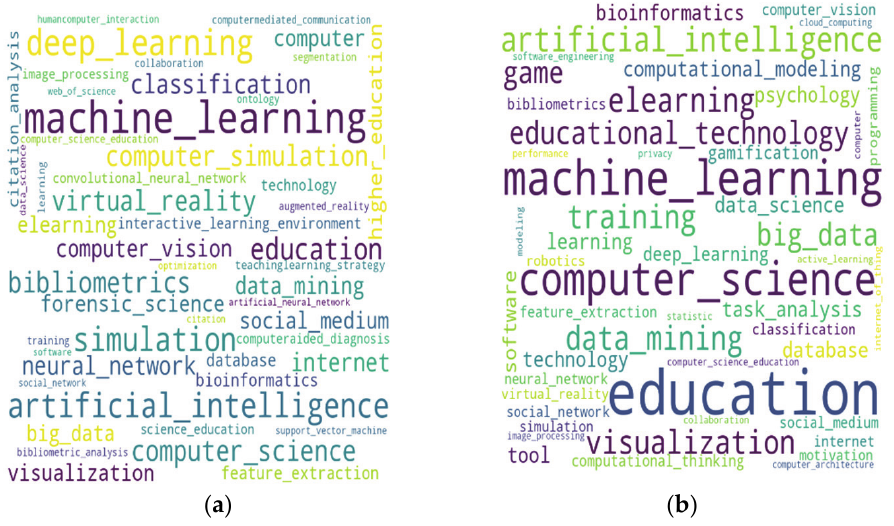
Figure 5. Two word clouds that compare results of the corner centrality value with the 50 most